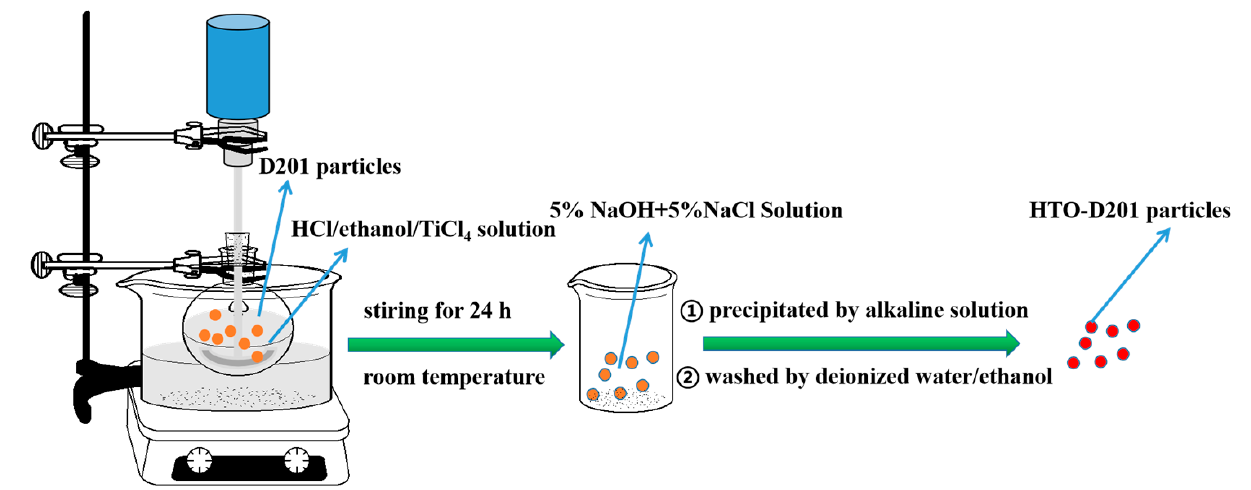
Figure 1. Fabrication process of HTO-D201.